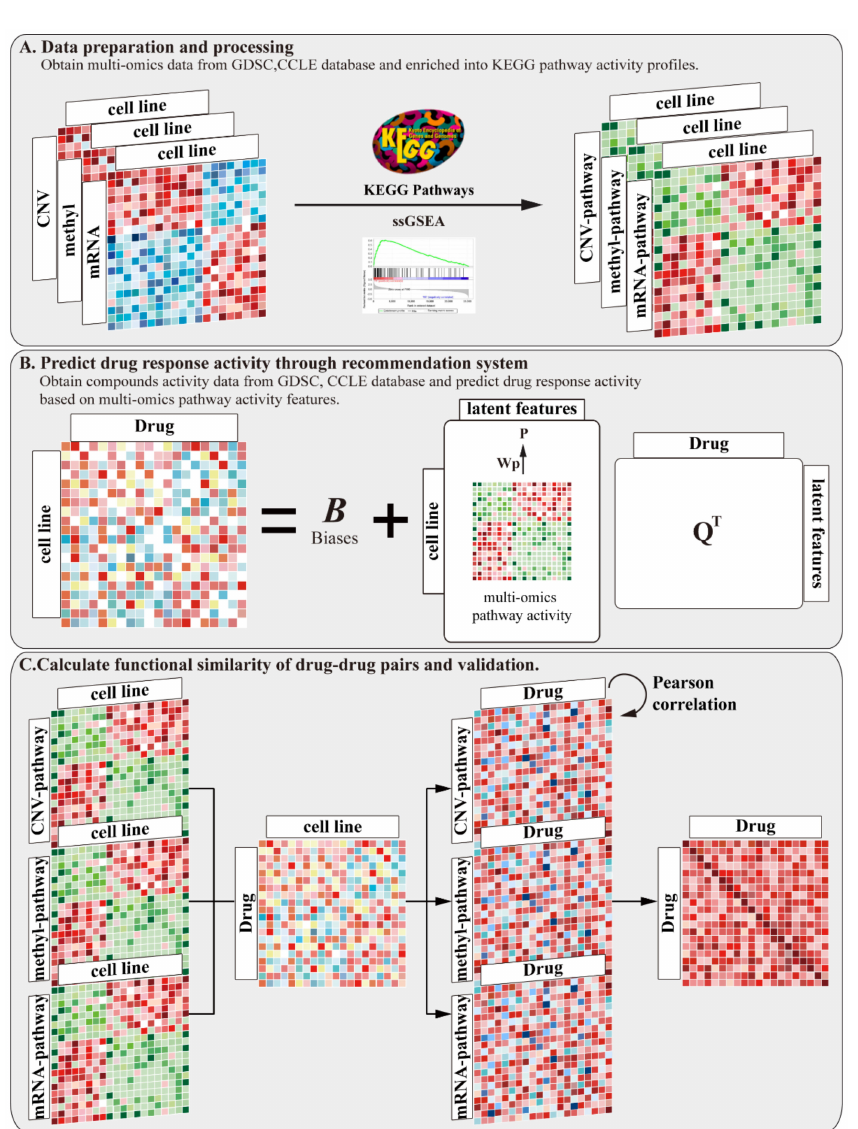
Figure 1. A pipeline to prioritize candidate compounds based on a drug functional similarity.